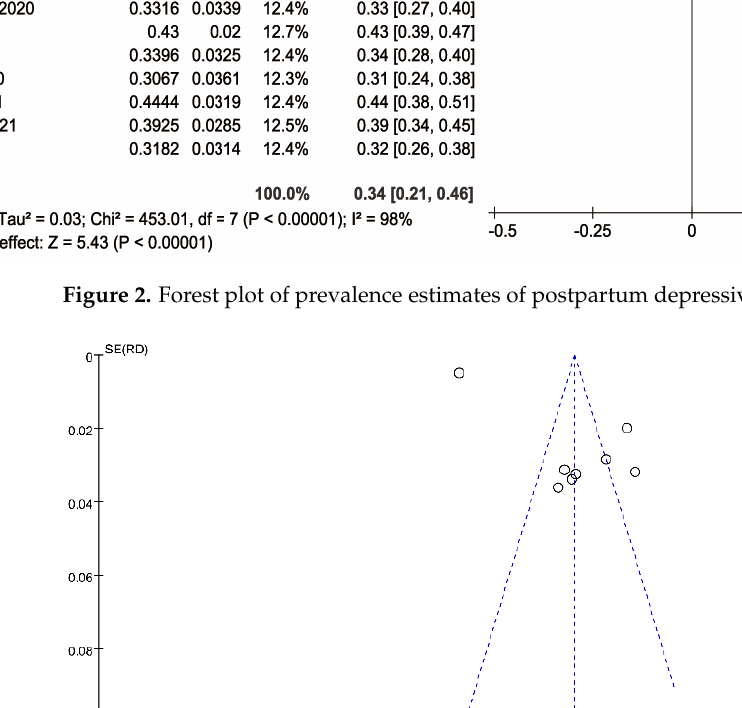
Figure 4. The symmetry of the funnel plot indicates no publication bias (see Figure